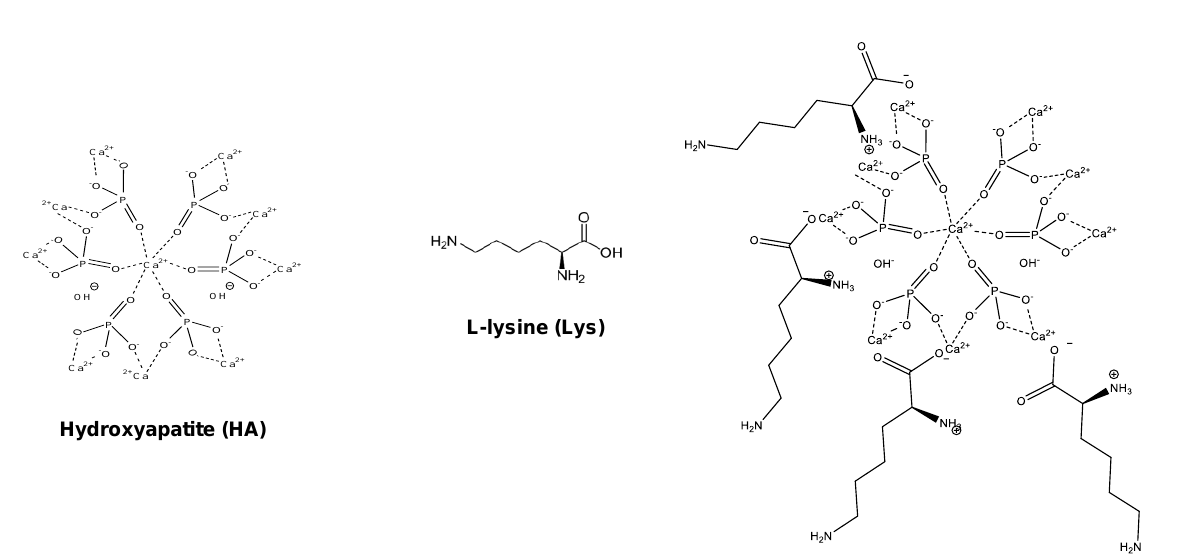
Scheme 1. Chemical structures of hydroxyapatite (HA) and L − lysine (Lys), as well as a simplified schematic representation of the hydroxyapatite/L − lysine (HA/Lys) complex.